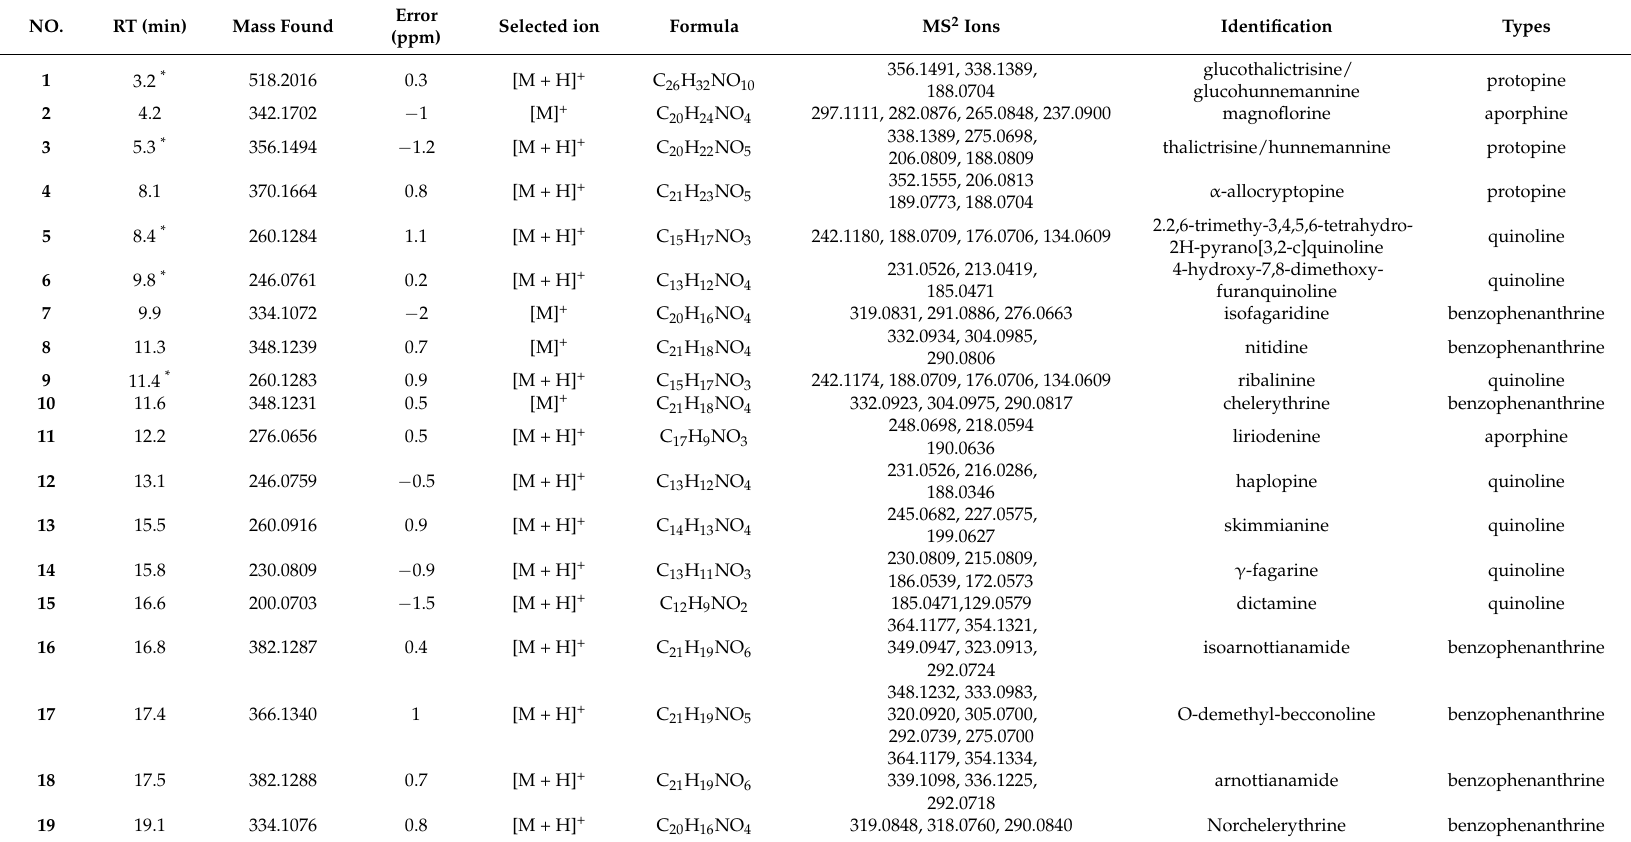
Table 1. MS data and identification results of the alkaloids in rat plasma after oral administration of Z. nitidum